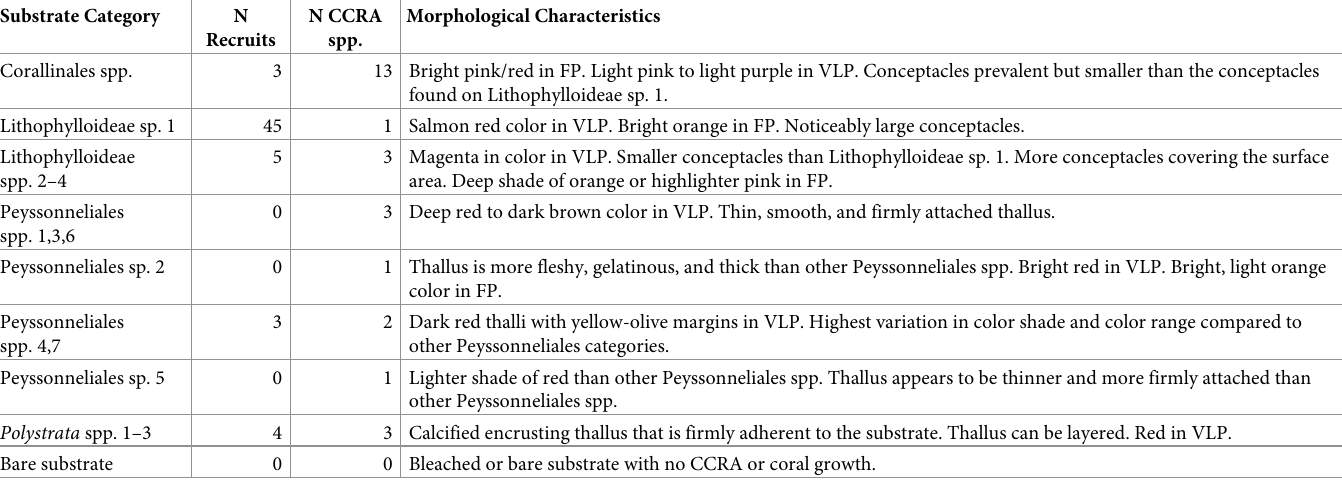
Table 1. Description of the nine substrate categories found on the recruitment tiles. N Recruits, number of coral recruits found on each substrate category; N CCRA spp., number of CCRA species included in each substrate category; Morphological Characteristics, characteristic features for each substrate category. FP: fluorescence pho- tography; VLP, visible light